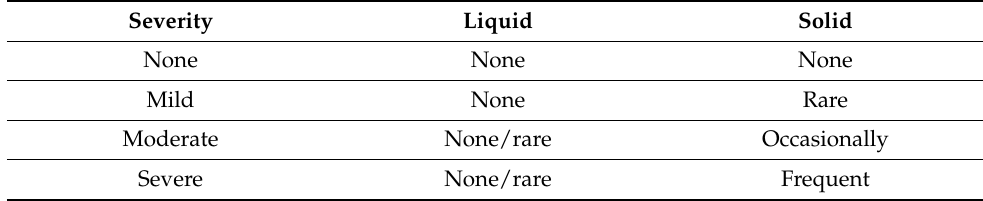
Table 2. Bazaz scale for grading of